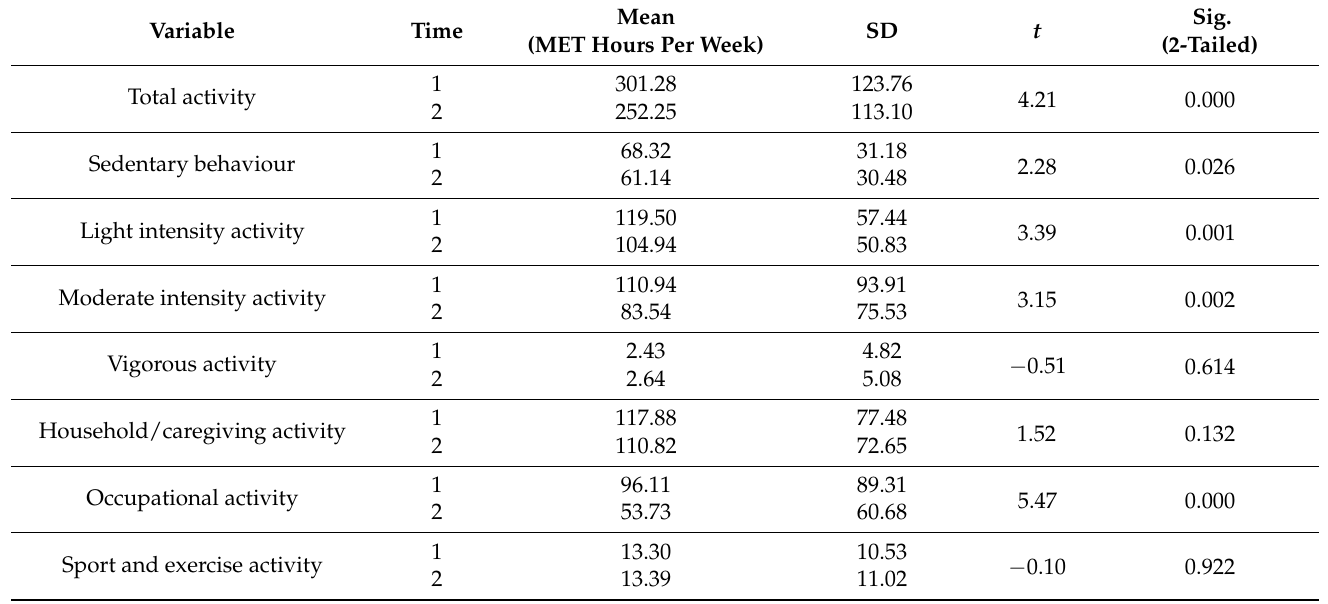
Table 5. Paired samples t -test representing PPAQ difference in MET scores between time 1 and time 2 (n = 82).